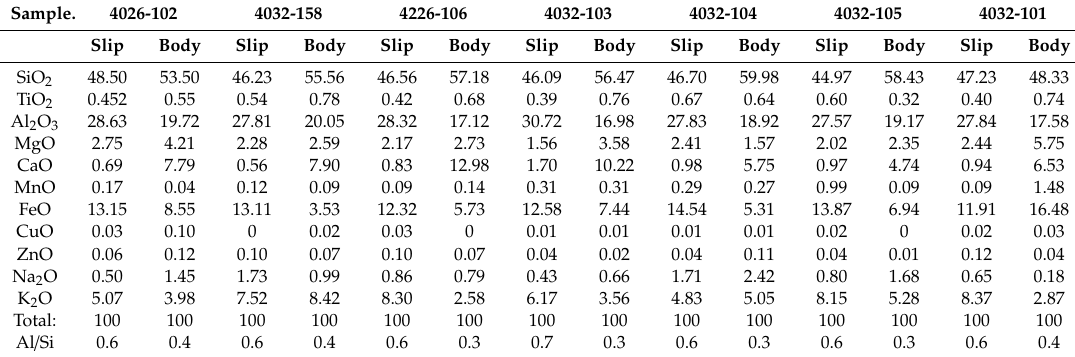
Table 4. Electron microprobe analysis (EMP) composition of slip and bodies from the di ff erent ceramic samples. Concentrations in